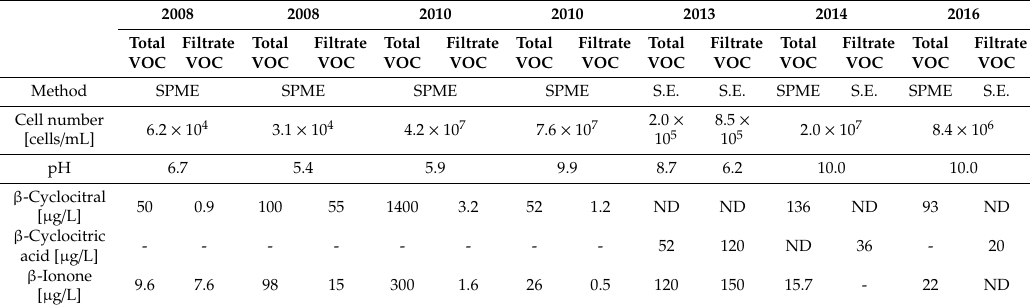
Table 1. Analysis results of volatile organic compounds (VOCs) using solid phase micro-extraction (SPME) and the typical solvent extraction methods from 2008 to 2016.